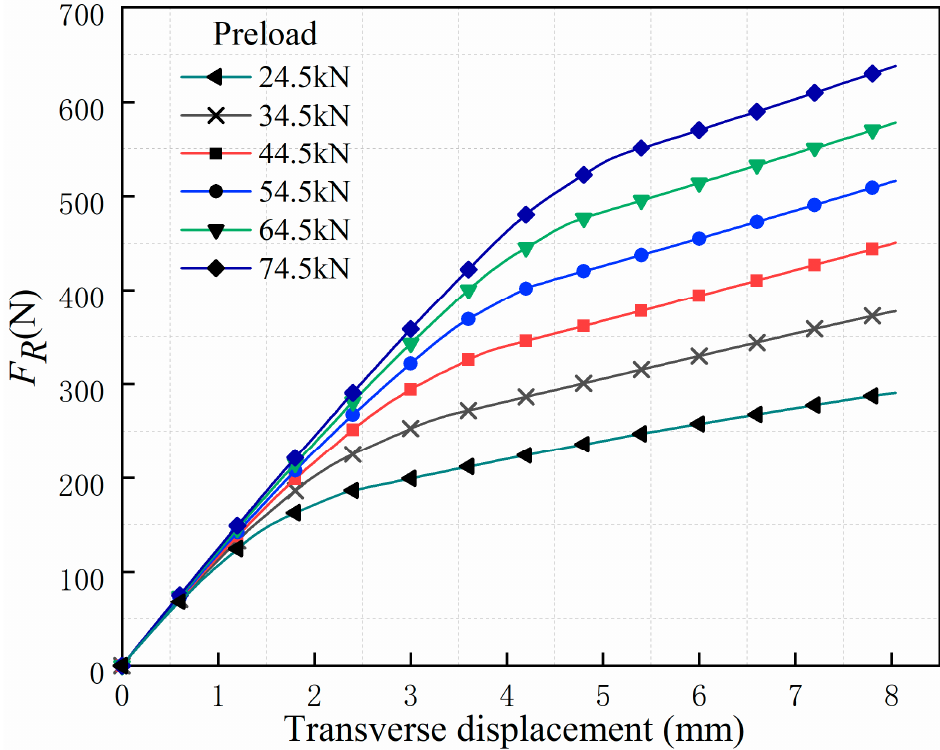
Figure 11. Reaction force–displacement curve under static transverse load.